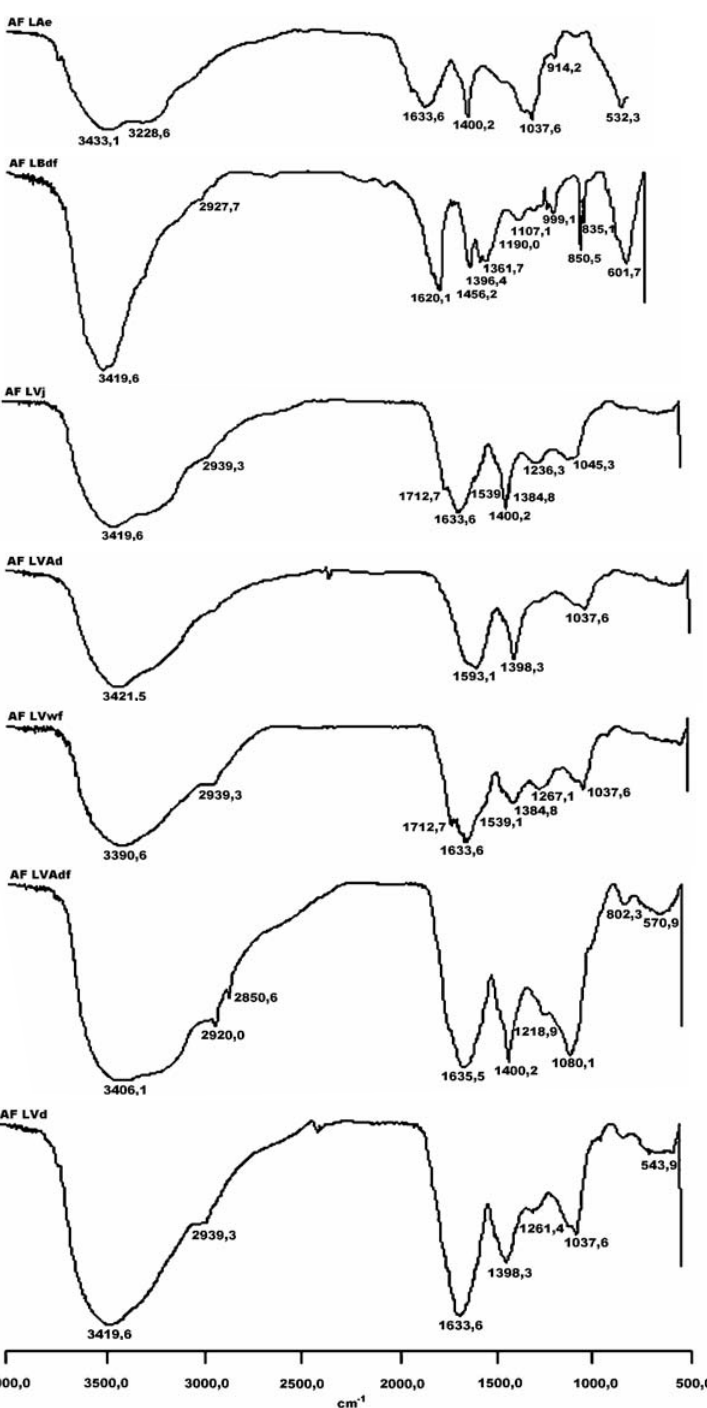
Figura 2. Espectros na região de infravermelho obtidos com transformada de Fourier de ácidos fúlvicos (AF) isolados do horizonte superficial dos sete Latossolos